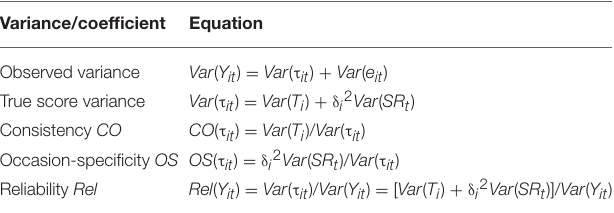
TABLE 1 | Variance decomposition and coefficients in the MTMS